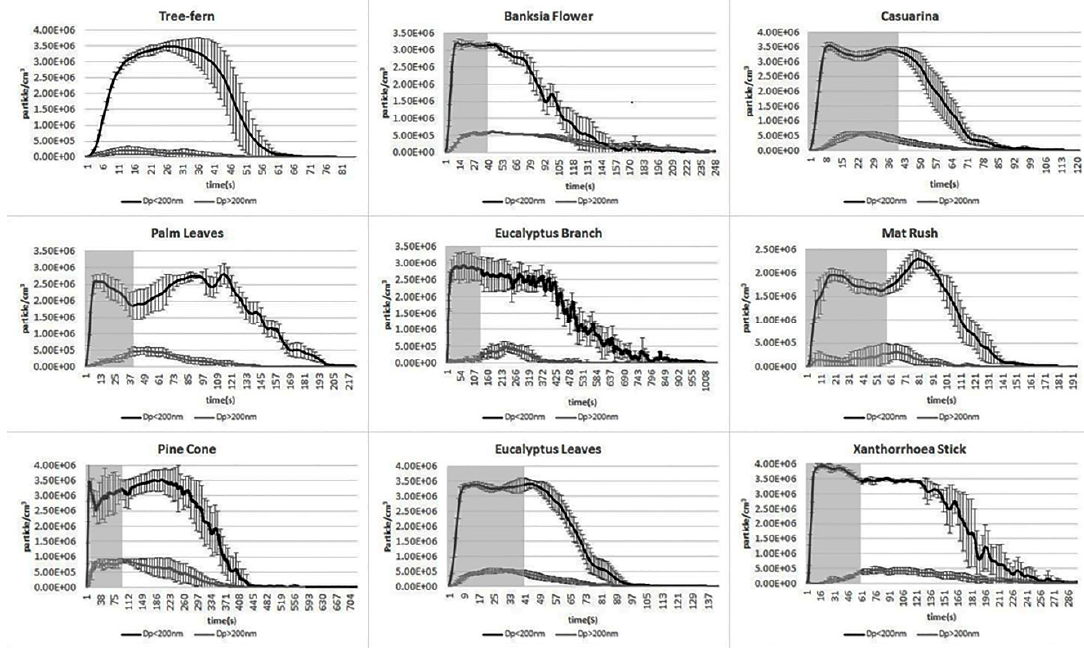
Figure 3. Fine particles with a diameter below 200 nm and coarse particulate matter with a diameter above 200 nm released from combustion processes. Error bars represent standard deviation of at least six replicates. Shaded areas represent the flaming phase of the combustion.